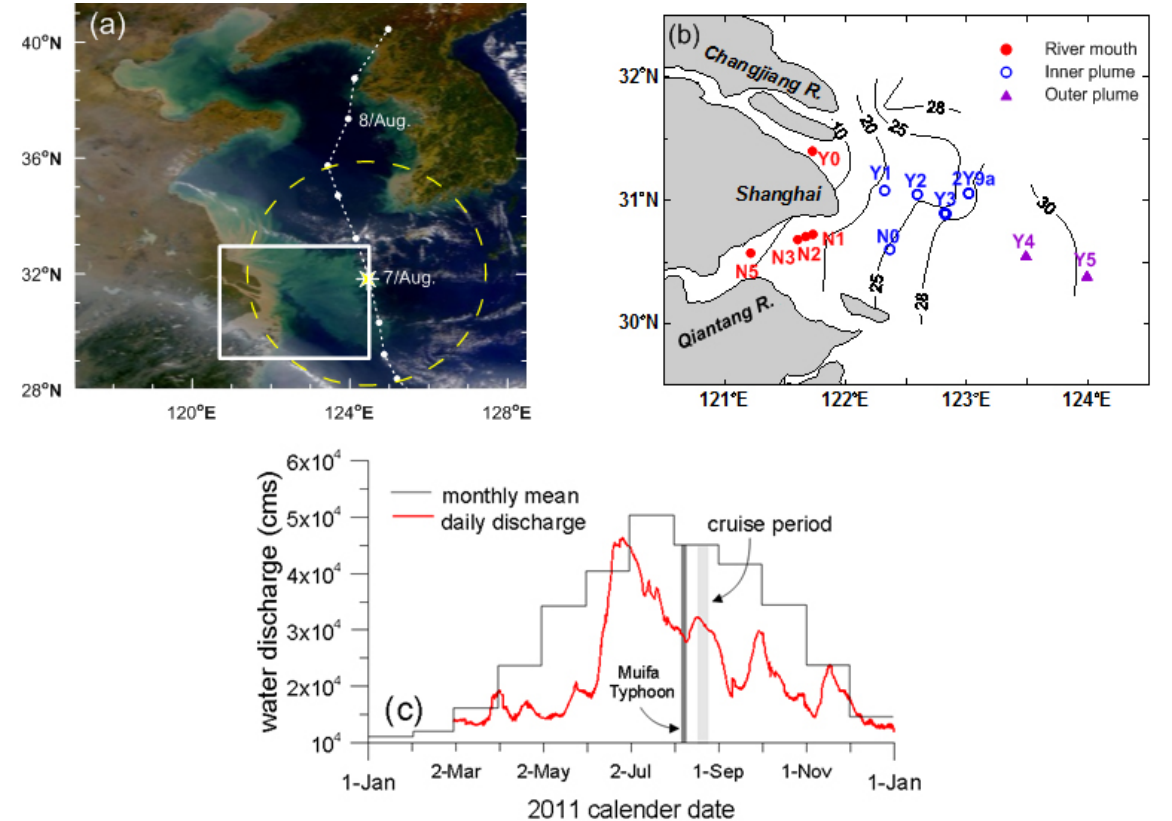
Fig. 1. (a) Satellite image of the Yellow Sea, the Bo Hai and the East China Sea. Note that turbid water is found in the coastal zone and the river mouths. The white rectangle represents our study site. The white dashed line is the trajectory of Muifa, and the yellow dashed circle indicates cloud coverage of Muifa (average wind speed > 14ms − 1 ) at 0.00a.m. UTC+8, 7 August. (b) Map of sampling stations. Contours stand for the sea surface salinity. The sampling stations are classified as river mouth ( • ), inner plume ( ◦ ) and outer plume ( N ). Station names are marked. (c) The long-term monthly mean water discharge (solid gray) and daily discharge (red curve) at Datong, the most downstream gauge of the Chang Jiang River. Dark gray bar represents the period influenced by Typhoon Muifa and light gray stands for the cruise